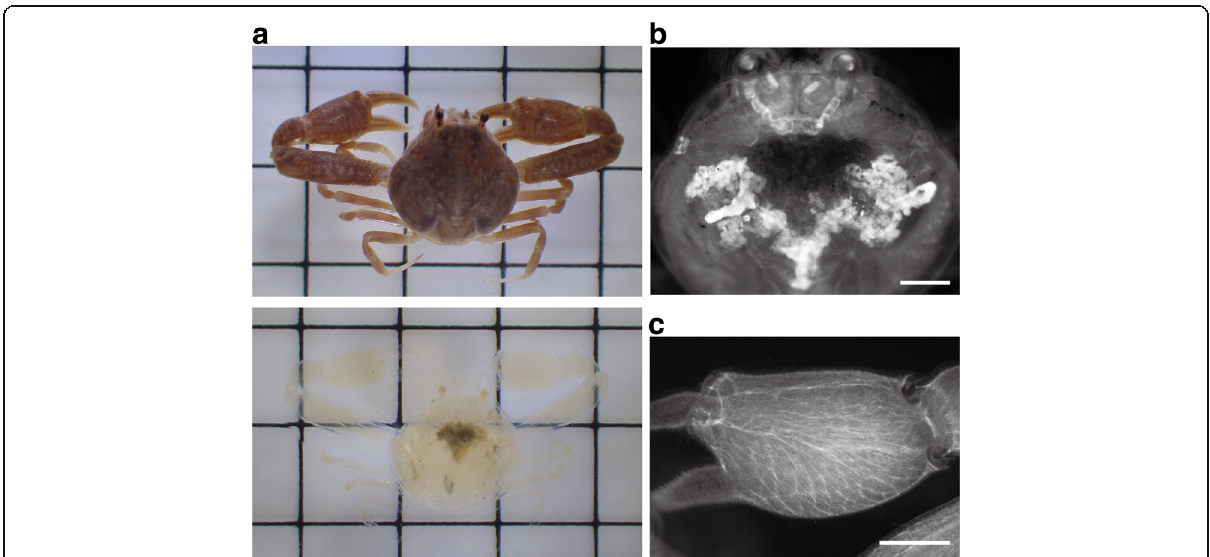
Fig. 4 Whole-mount clearing of the marine crab, Philyra sp. a Specimen before (top) and after (bottom) clearing. Dark parts seen through the carapace are the gut content. Grid = 5 mm. b , c Nuclear staining with propidium iodide (PI). Dorsal view through the carapace and the right cheliped. Scale bars = 1